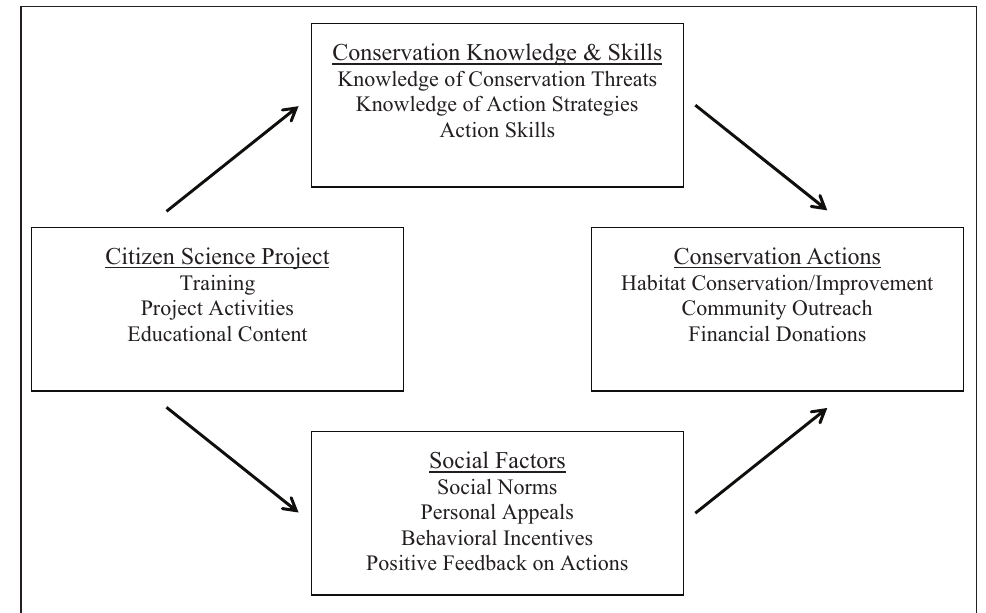
Figure 1: Model depicting a citizen science project’s influence on its volunteers’ transition from citizen science partici- pation to conservation